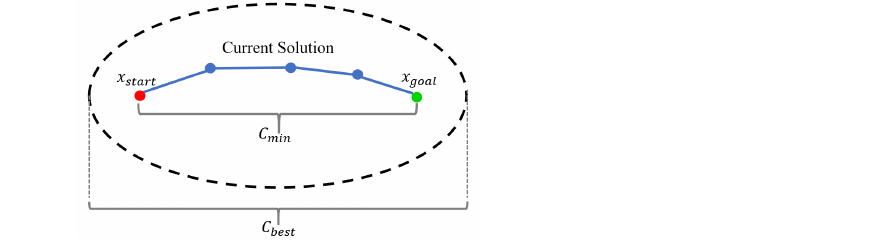
Figure 2. Informed RRT* (rapidly-exploring random tree): Once a path is generated, an ellipse is determined by the start state, goal state and path cost.